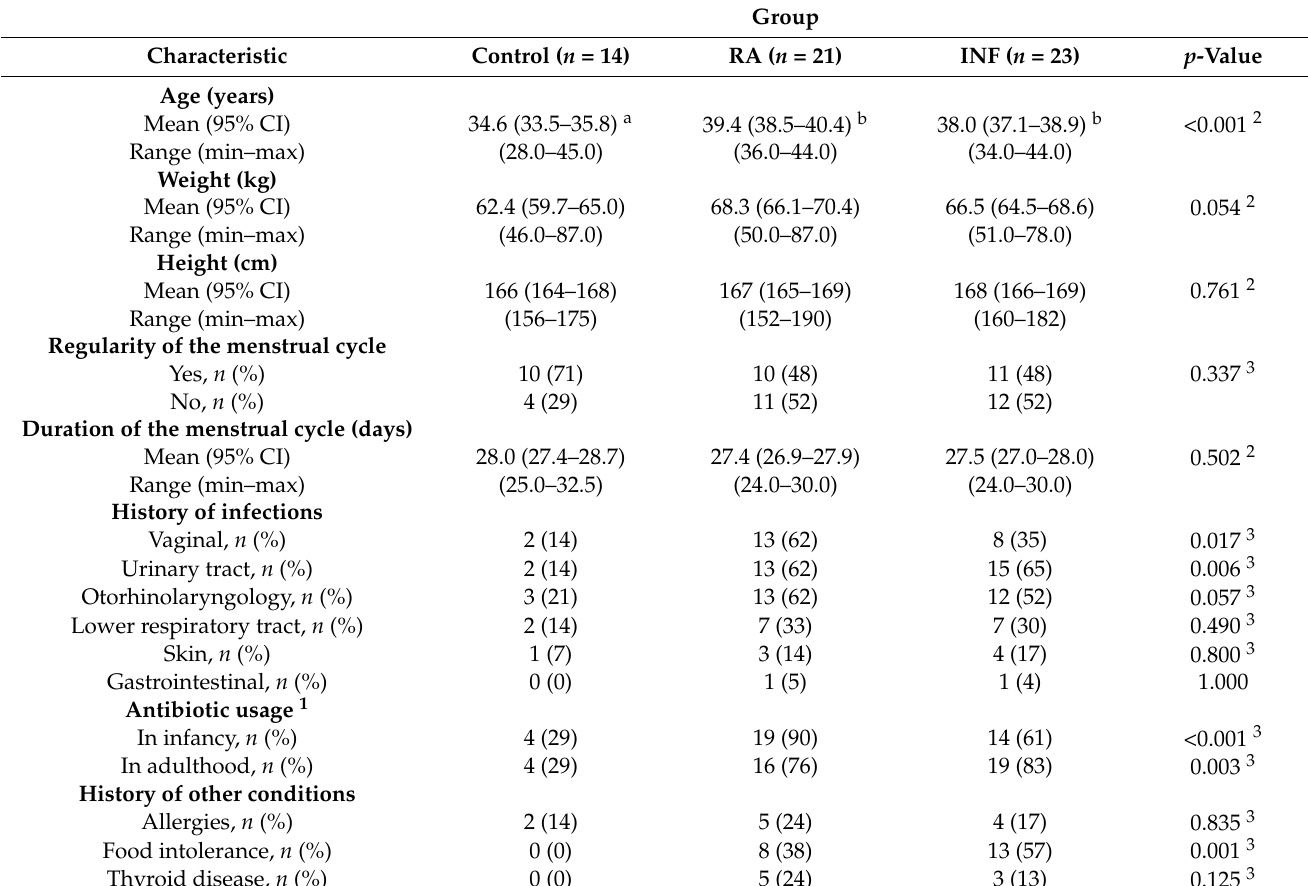
Table 1. Characteristics of the participants ( N = 58) which included fertile women (Control group), women with a history of repetitive abortion (RA group), and women with infertility of unknown origin (INF